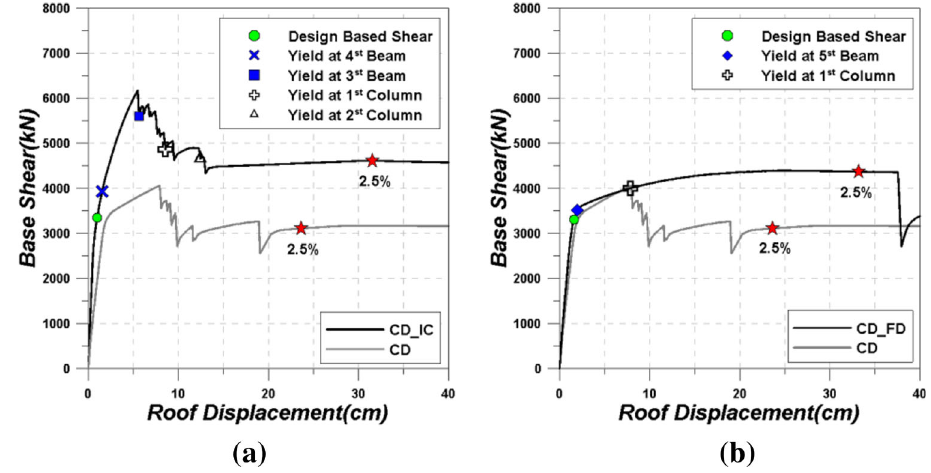
Fig. 19 Pushover curves of the retrofitted staggered wall structures. a Model CD_IC and b Model